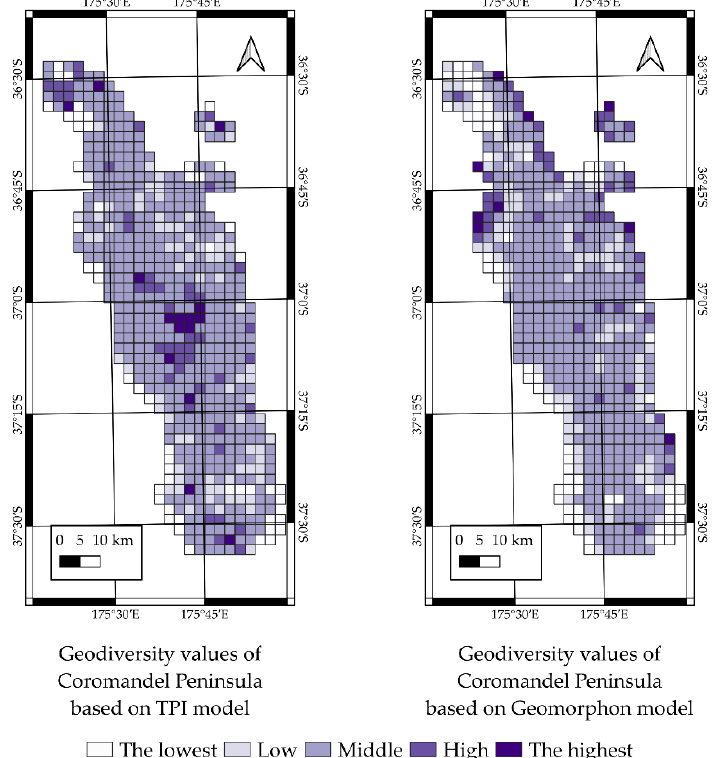
Figure 5. Geodiversity values of Coromandel Peninsula for geosite recognition, based on landform geomorphological models: TPI and Geomorphon. Equal interval mode of evaluation.